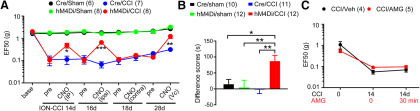
 Chemogenetic inhibition of TRPV1+ afferent terminals attenuates mechanical hyperalgesia and ongoing pain in mice with ION-CCI. A, Effects of CNO on mechanical hyperalgesia following ION-CCI in mice expressing inhibitory DREADD in TRPV1-LN neurons (TRPV1Cre;R26LSL-hM4Di; hM4Di) or TRPV1Cre mice (Cre). CNO was repeatedly injected intraperitoneally (40 µg/20 µl), to ipsilateral (ipsi; 20 µg/10 µl) or contralateral (contra; 20 µg/10 µl) V2 skin or intra-Vc (Vc; 0.1 µg/1 µl) at indicated time points. Mechanical sensitivity is presented as EF50 (the mechanical force that produced a 50% response frequency) in the ipsilateral V2 skin; *p < 0.05, **p < 0.01, ***p < 0.001 in Bonferroni post hoc test following two-way ANOVA. Throughout the figures, numbers in parenthesis represent the number of mice in each group. B, Preconditioning habituation started at four to five weeks after CCI or sham surgery. Following the habituation period, the mice received intra-Vc microinjection of vehicle (0.5-µl saline) in the ipsilateral side and paired with a chamber for 30 min. Four hours later, the same mouse received 0.5-µl CNO paired with the other conditioning chamber for 30 min. On the following test day, the mice were placed in the CPP chambers with free access to all chambers to measure time spent in both chambers. Mice were recorded for 15 min, and difference scores were calculated by subtracting time spent in CNO-paired chambers before conditioning from the time after conditioning; *p < 0.05, **p < 0.01 in Bonferroni post hoc test following two-way ANOVA. C, The effects of AMG9810 (100 nmol/10 µl), a TRPV1 antagonist, or vehicle injected into the ipsilateral V2 skin on mechanical sensitivity in the ipsilateral V2 skin of mice with ION-CCI.